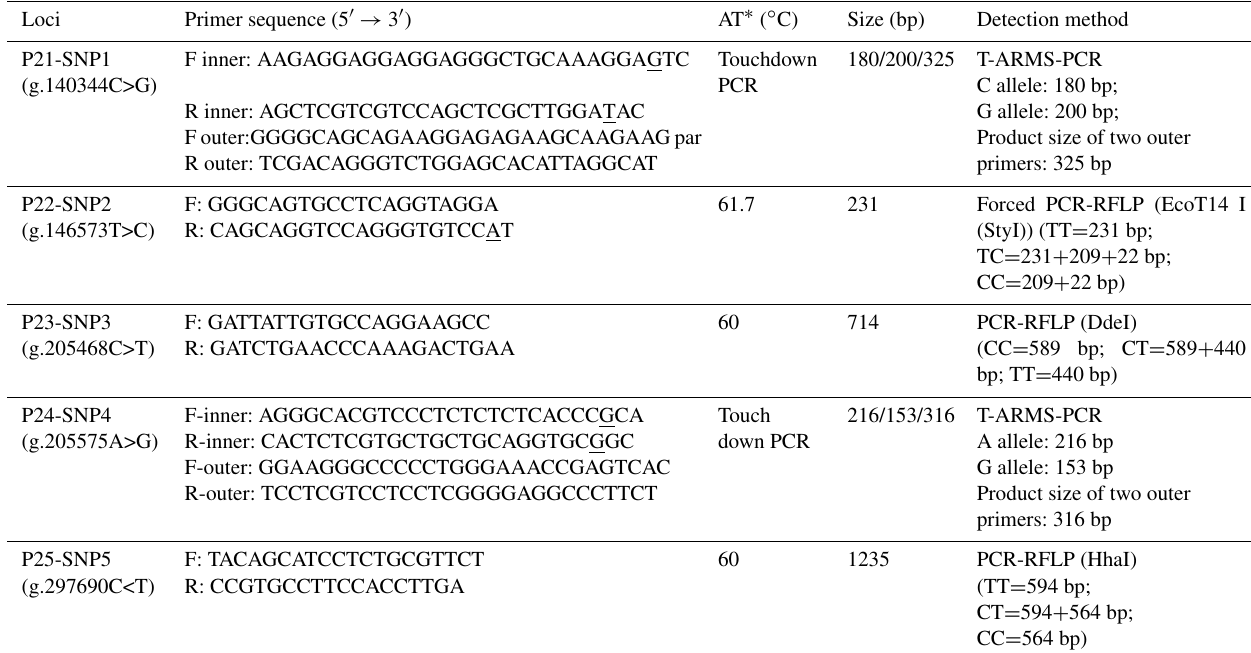
Table 2. PCR primer sequences for ATBF1 gene genotyping in cattle; bp: base pairs.